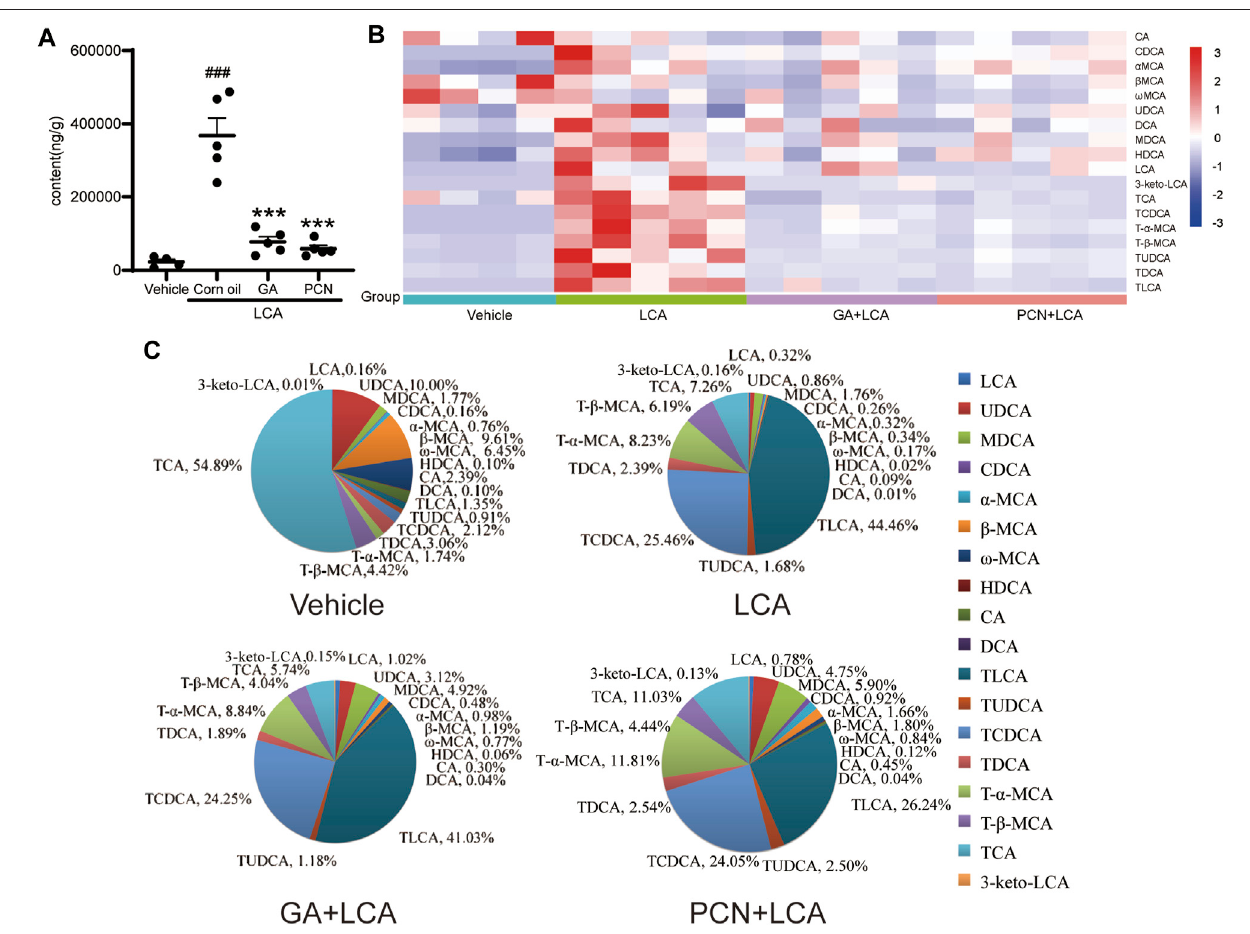
FIGURE3| EffectofGAontheBAcompositionintheliverfromLCA-inducedmodelmice. (A) AmountoftotaldetectedBAs; (B) heatmapofhepaticindividualBAs (blue represents downregulating, and red represents upregulating, compared with the vehicle group); (C) bile acid composition of the hepatic BA pool. Data are expressed as mean ± SD ( n = 5). ### p < 0.001 vs. vehicle group; ppp p < 0.001 vs. LCA group.